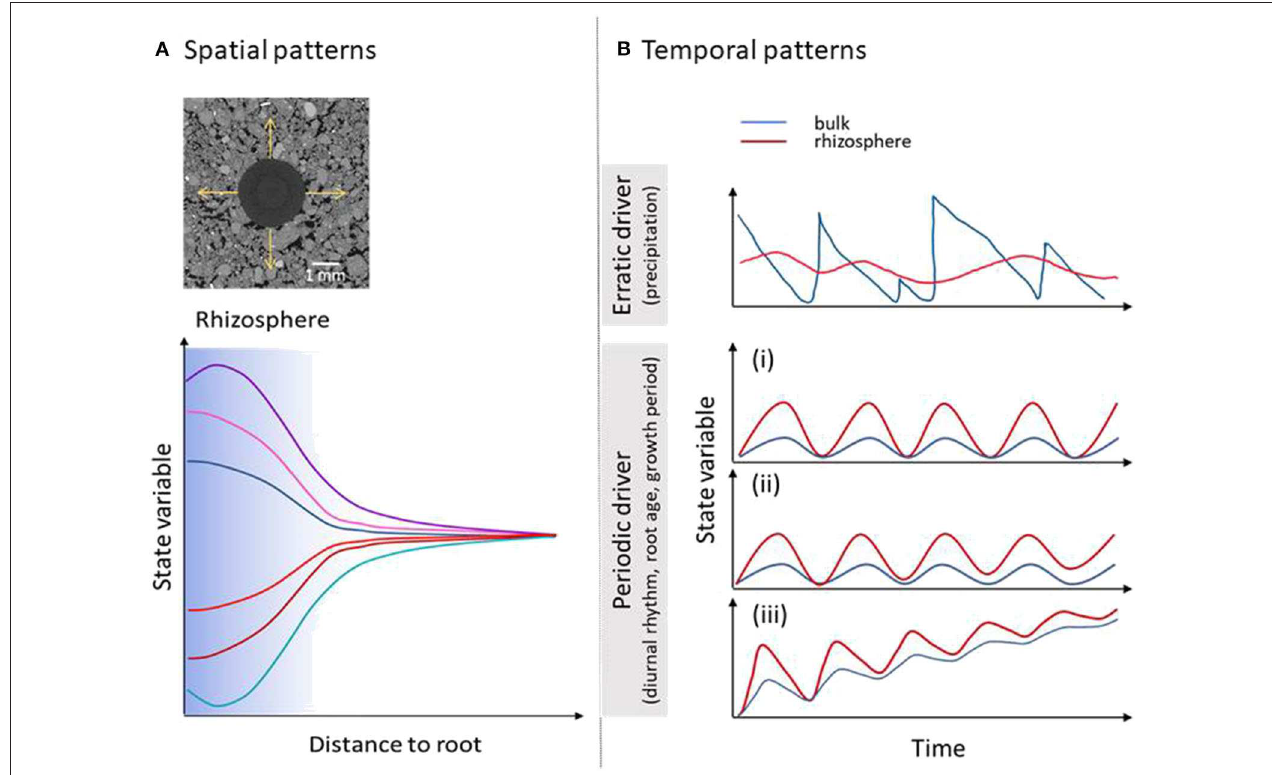
FIGURE 3 | Hypothetical rhizosphere patterns. (A) State variables increase or decrease with increasing distance from the root surface. In specific cases the minimum or maximum is found at some distance from the root surface. Shaded area represents the width of the rhizosphere defined as the distance at which the state variable is C bulk + 5% of C max , C bulk -5% of C min , respectively, in accordance with de Parseval et al. (2017). Please note that the width of the rhizosphere is dependent on the process in question, ranging from several µ m to mm. (B) State variables fluctuate in time. For a number of processes oscillations are expected to be larger in the rhizosphere, i.e., due to day-night cycle, changes of root activity with age and time during growth period. For state variables strongly affected by erratic external drivers like the soil water content the opposite can be found, i.e., oscillations are buffered by specific rhizosphere properties like mucilage concentration. For periodic drivers three scenarios are hypothesized: (i) state variable returns to bulk soil value having no temporal trend. (ii) State variable in the rhizosphere does not return to initial bulk soil value, while bulk soil value shows no temporal trend. (iii) State variable in rhizosphere and bulk soil both change over time approaching new equilibrium. For simplicity all hypothetical examples for periodic drivers show state variable in the rhizosphere being higher than in the bulk soil, for all cases mirror images could have been drawn as